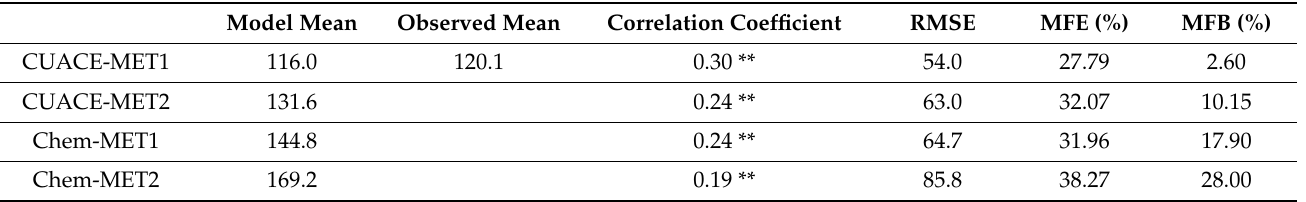
Table 6. Statistical analysis of PM 2.5 concentrations of four tests in the Pollution Episode II from